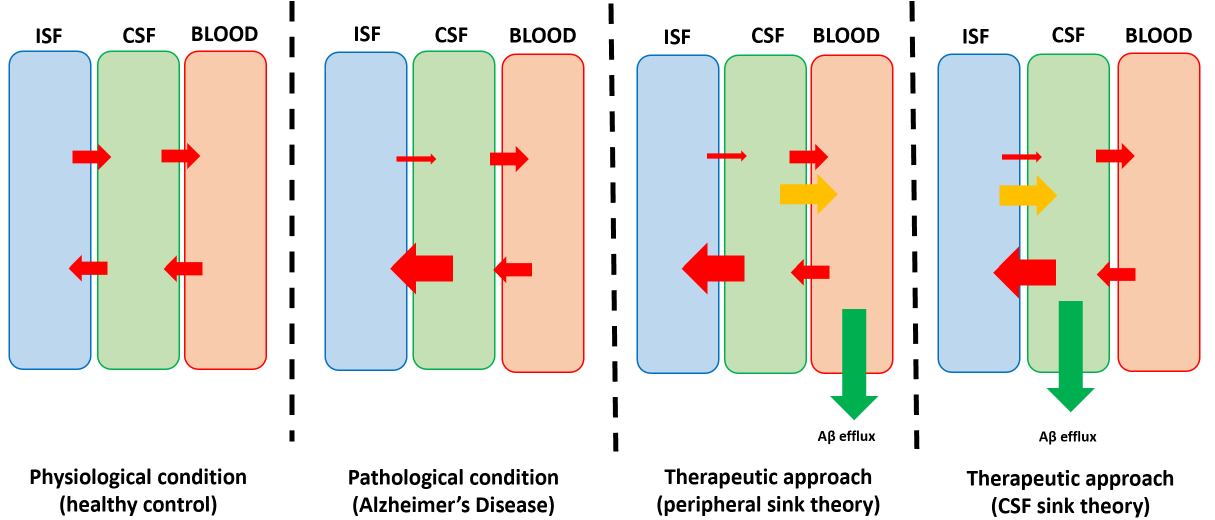
Figure 2. A β dynamics in physiological, pathological, and interventional conditions (peripheral sink therapeutic strategy and CSF-sink therapeutic strategy). The red arrows indicate A β influx/efflux. In AD, the decreased A β efflux is concomitant with the increased A β influx. In the peripheral sink therapeutic strategy, the increased A β elimination from the peripheral circulation (green arrow) stimulates the A β efflux from the CSF (yellow arrow), but not from the brain. In the CSF-sink therapeutic strategy, the increased A β elimination from the CSF (green arrow) stimulates the A β efflux from the interstitial fluid (ISF; yellow arrow).